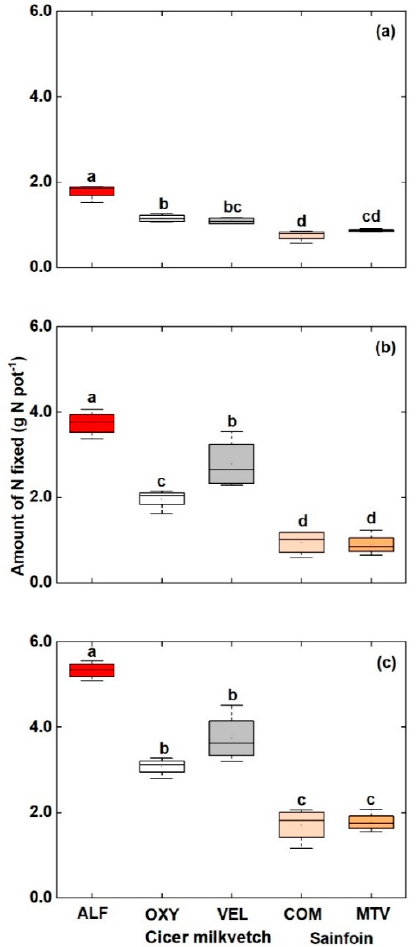
Figure 2. Amount of N fixed (g N pot − 1 ) in the shoot ( a ), root ( b ), and whole plant ( c ) among legume species and cultivars ( n = 4) grown under controlled environment conditions. ALF = alfalfa, OXY = Oxley II milkvetch, VEL = Veldt milkvetch, COM = Common sainfoin, MTV = Mountainview sainfoin. The box is comprised of the 75th percentile, median, and 25th percentile, while the upper and lower whiskers are the maximum and minimum values, respectively. Boxes with the same letters indicate no significant di ff erences among legume cultivars within a panel ( p > 0.05) according to Tukey’s HSD test.